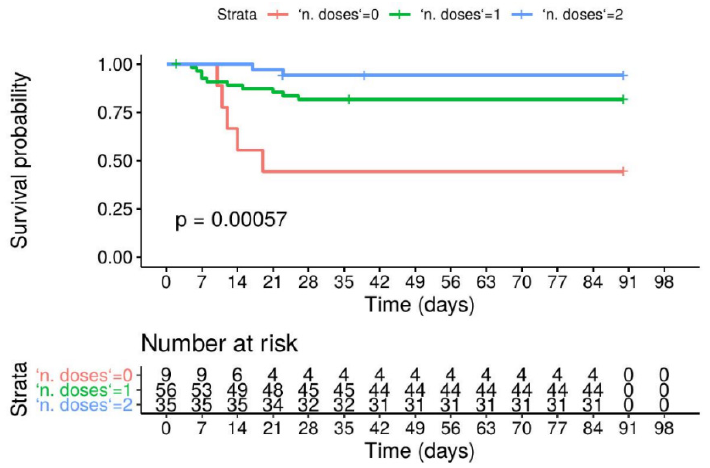
Figure 2. Kaplan–Meier survival estimates for COVID-19-related mortality depending on vaccination status (unvaccinated, partially vaccinated and fully vaccinated residents, log-rank test).